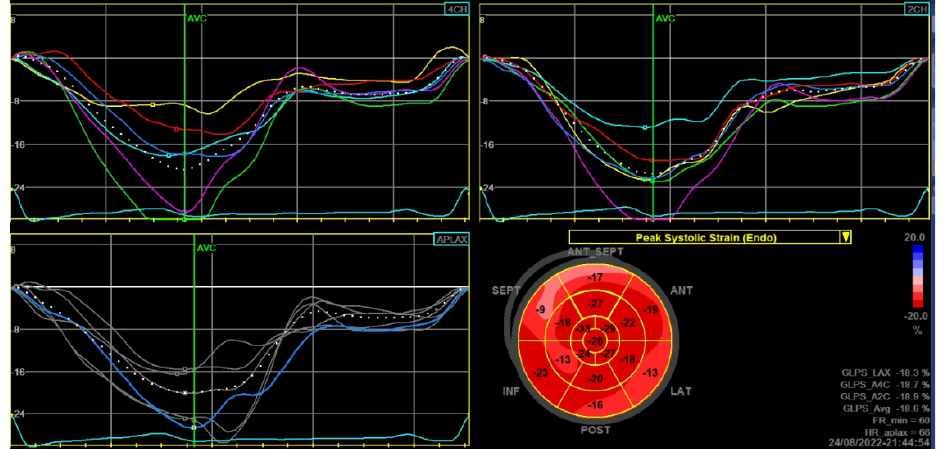
Figure 3. Global longitudinal strain: mildly reduced peak systolic strain (Endo) - global longitudinal peak strain average (GLPS_Avg) of − 18.6%.